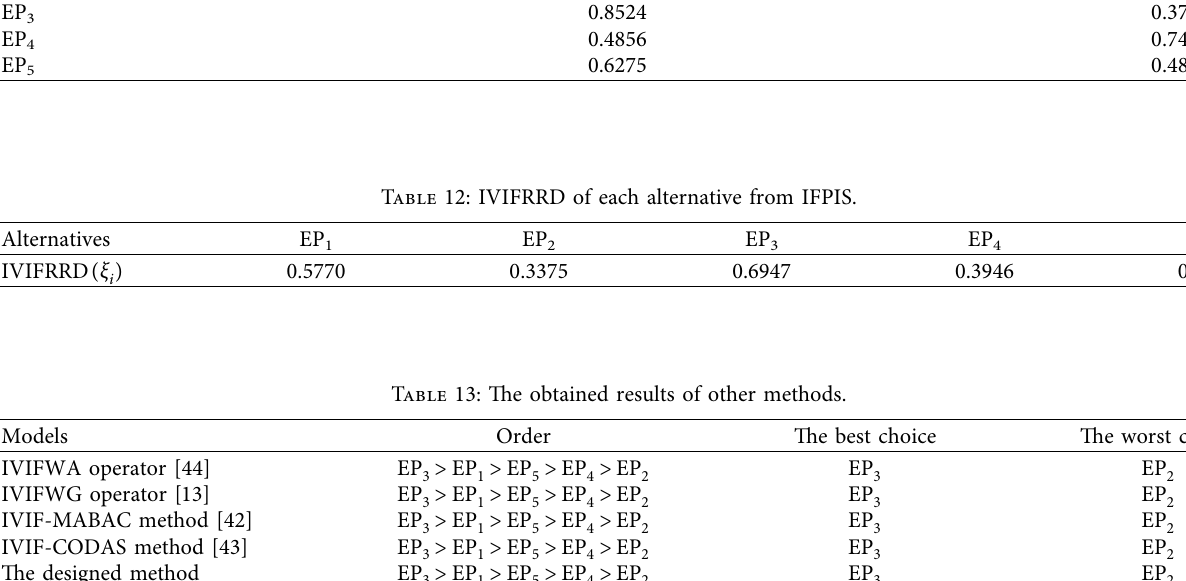
) of every alternative. i